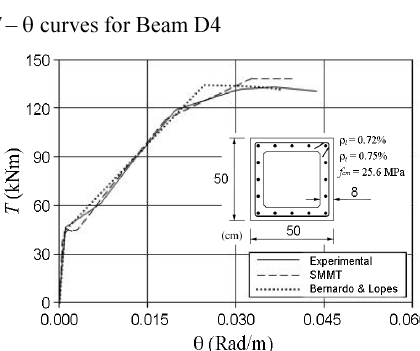
Fig. 8. T – θ curves for Beam A2